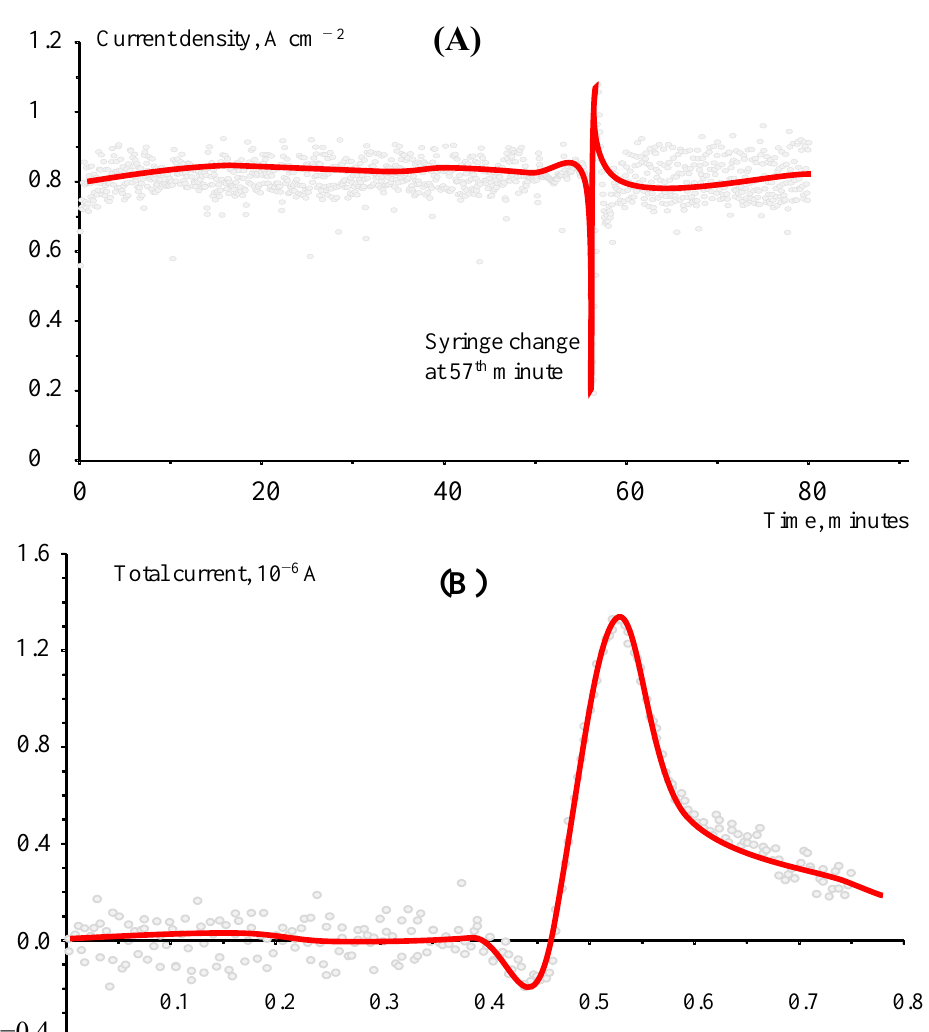
Figure 5. Crossover study through the N212 membrane for the solution of 1 M NaBrO 3 in 1 M H 2 SO 4 pumped at a 1 mL min − 1 rate at constant temperature of 60 ◦ C and voltage of 0.9 V: ( A ) Current density vs. time; ( B ) Potential dependence of current obtained by determining bromide anion by differential pulse voltammetry at the 60th minute of the experiment. For both graphs, the red line is the approximated value of chaotic momentary fluctuations (pale gray